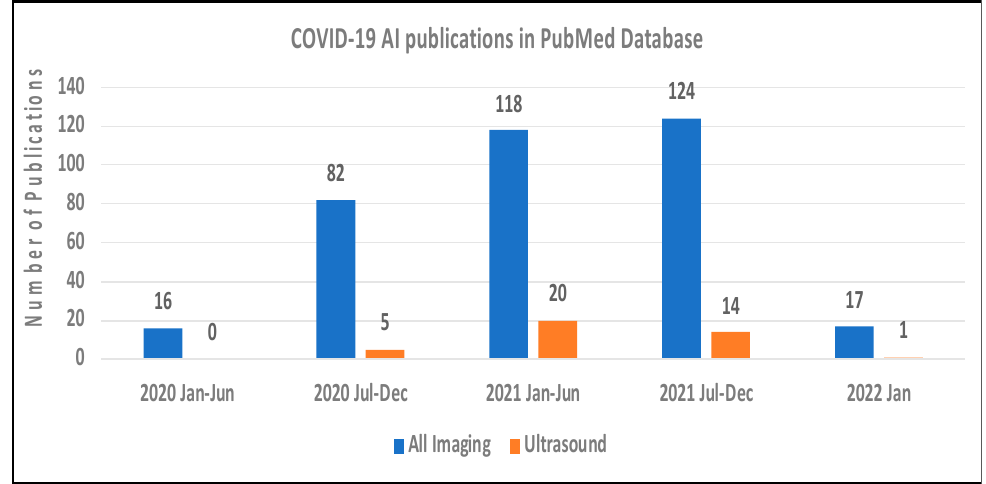
Figure 1. The number of COVID-19 AI publications based on ultrasound (orange bars) and CT, X-ray and ultrasound combined (blue bars) in PubMed Database, as of 17 January 2022.